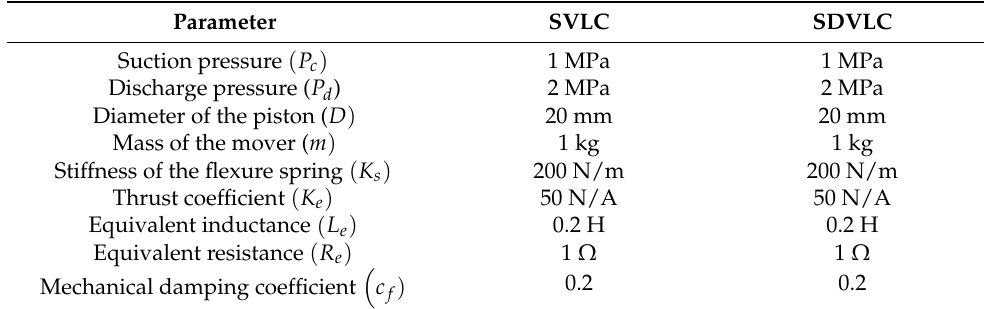
Table 2. The parameters of the linear compressor.